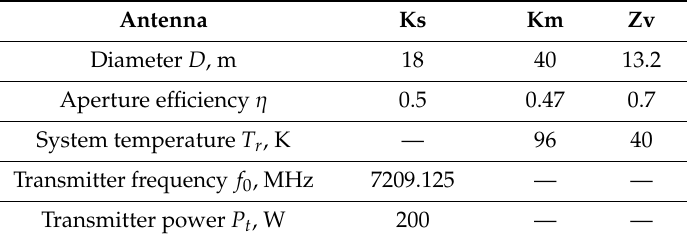
Table 1. The Performance Characteristics of the Radio